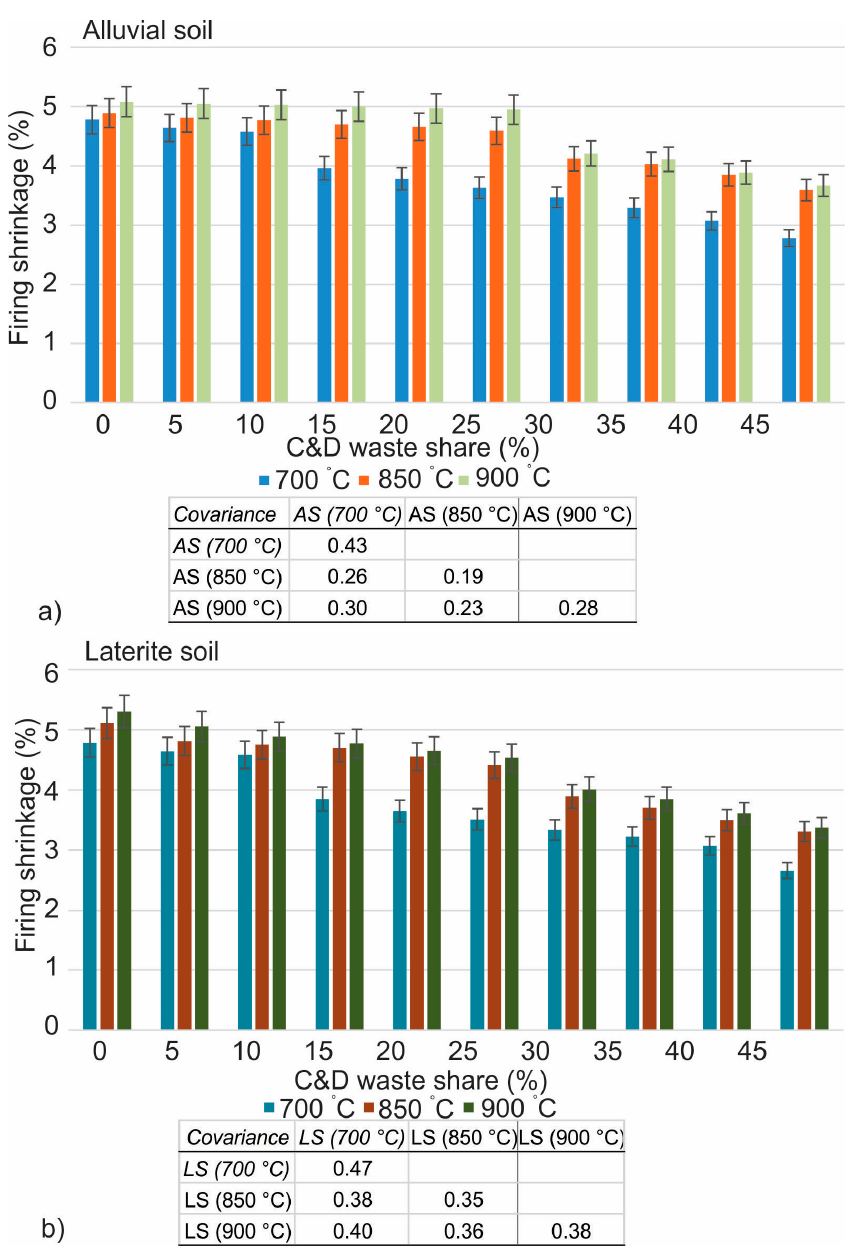
Figure 8. Firing linear shrinkage of mixed C&D waste in alluvial ( a ) and laterite ( b ) soils.